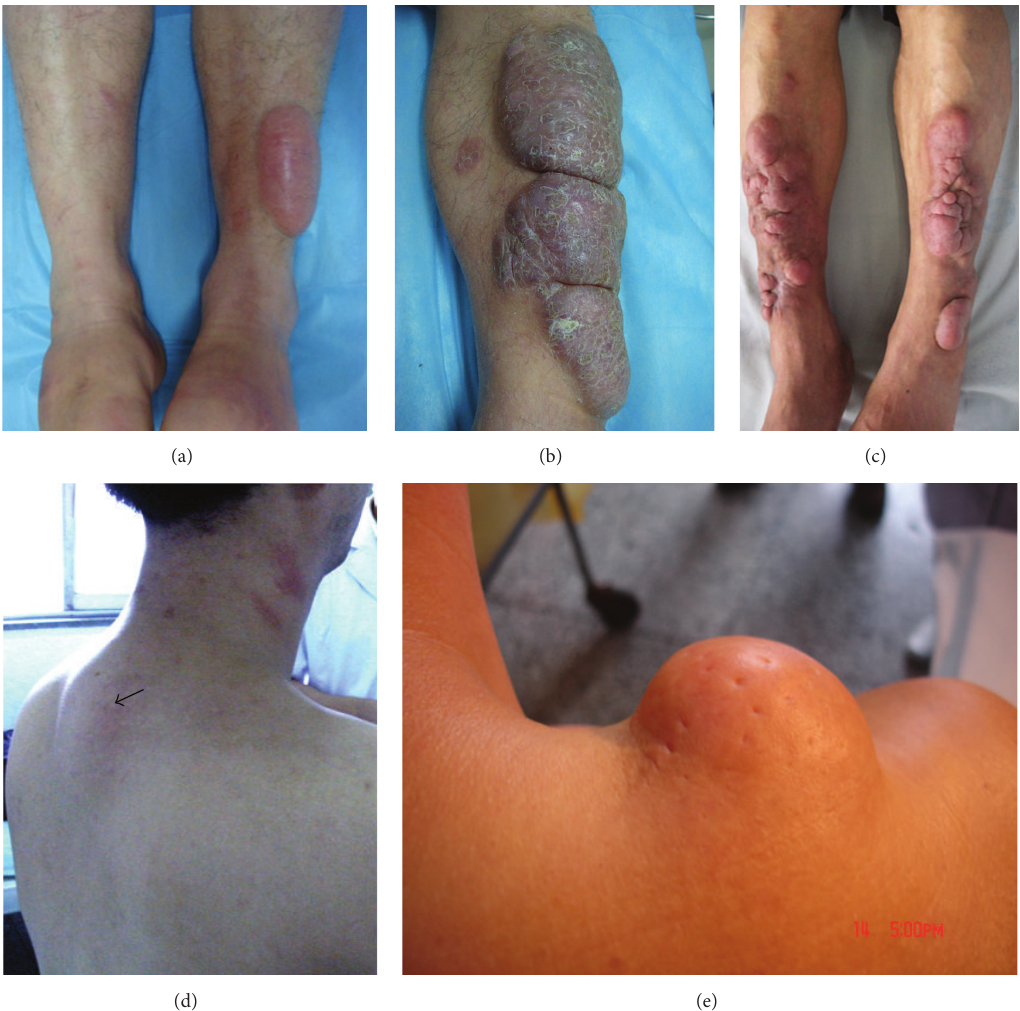
Figure 4: Tumor variant. (a) An olive-like, tense, and erythematous tumor with smooth surface on the extensor of left lower leg. (b) An erythematous, lobulated tumor with scales and crusts on the extensor of left lower leg. (c) Multiple erythematous, dermatofibrosarcoma- protuberans-like tumors, and nodules on the extensors of lower legs. (d) A skin-color, olive-like tumor at the interscapular region. (e) A skin-color, hemisphere tumor with orange peel-like appearance on the right